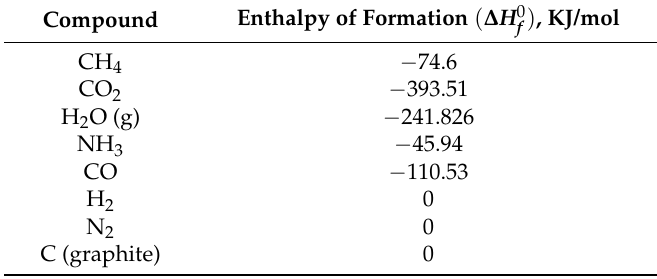
Table 1. The standard enthalpy of formation for various compounds used in this study